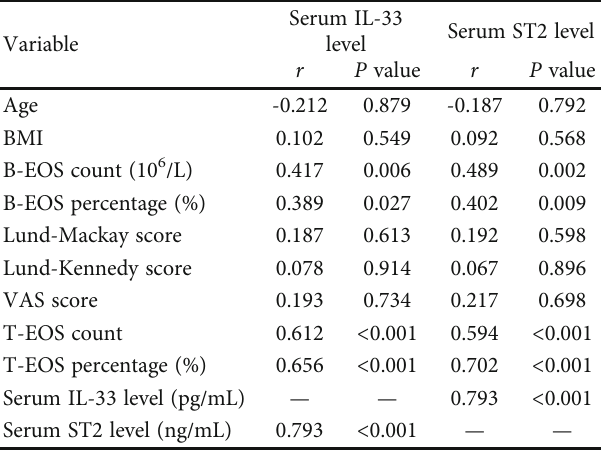
ST2: suppressor of tumorigenicity 2; CRSwNP: chronic rhinosinusitis with nasal polyps; BMI: body mass index; B-EOS: blood eosinophil; VAS: visual analogue scale; T-EOS: tissue